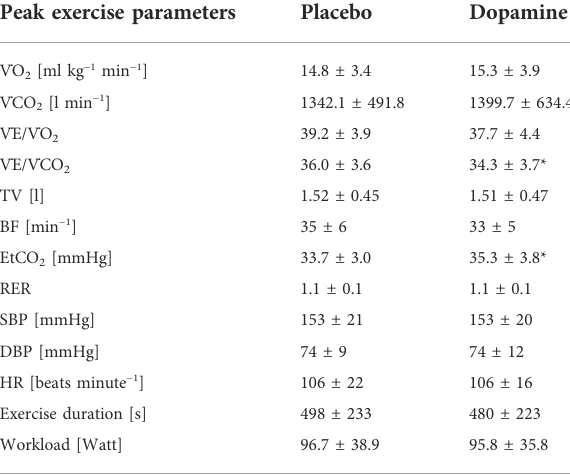
TABLE 3 The effect of dopamine on peak exercise parameters. Peak exercise parameters Placebo Dopamine